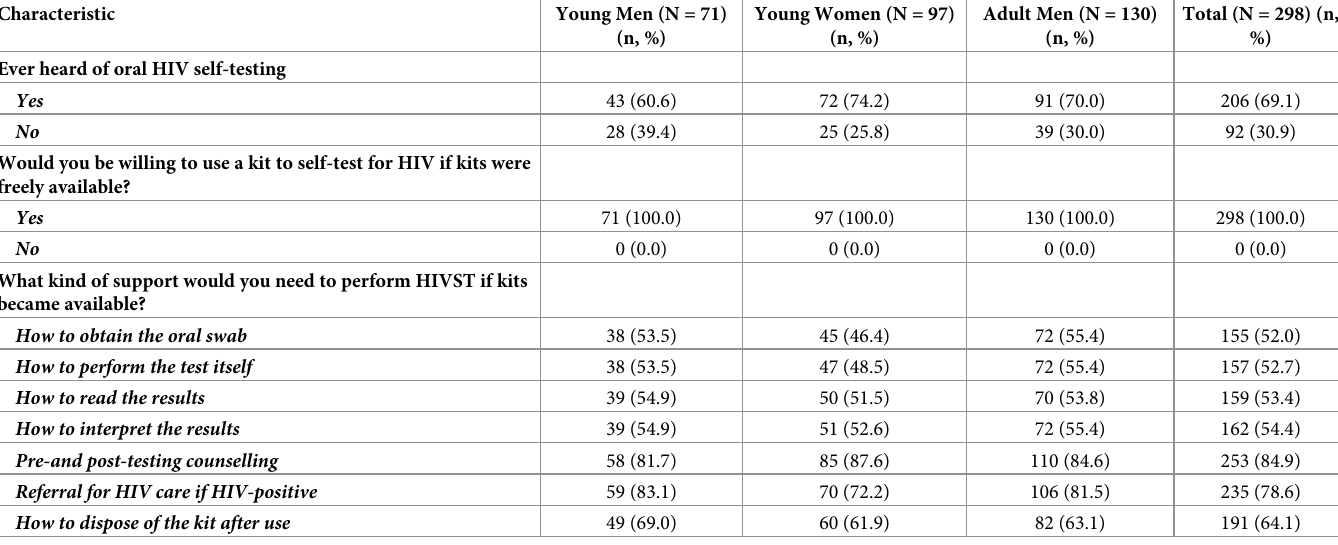
Table 3. Ever heard of HIV self-testing and willingness to self-test for